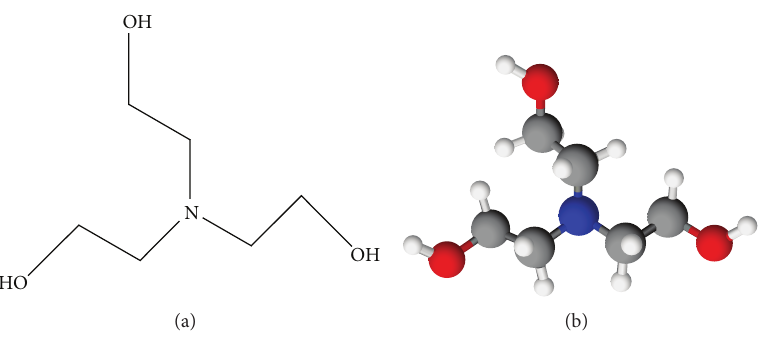
Figure 1: Triethanolamine (C 6 H 15 NO 3 : TEA): (a) molecular structure and (b) optimized ball and stick